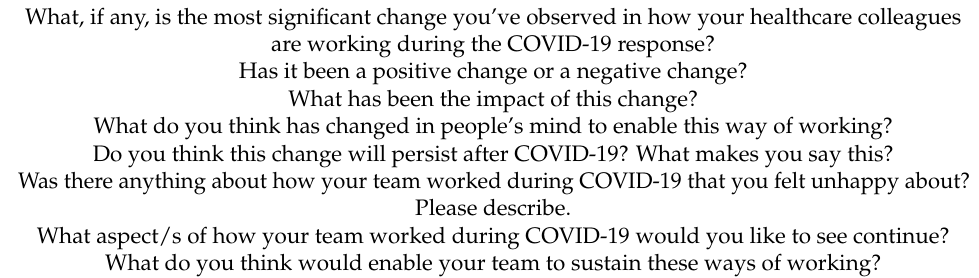
Please describe.